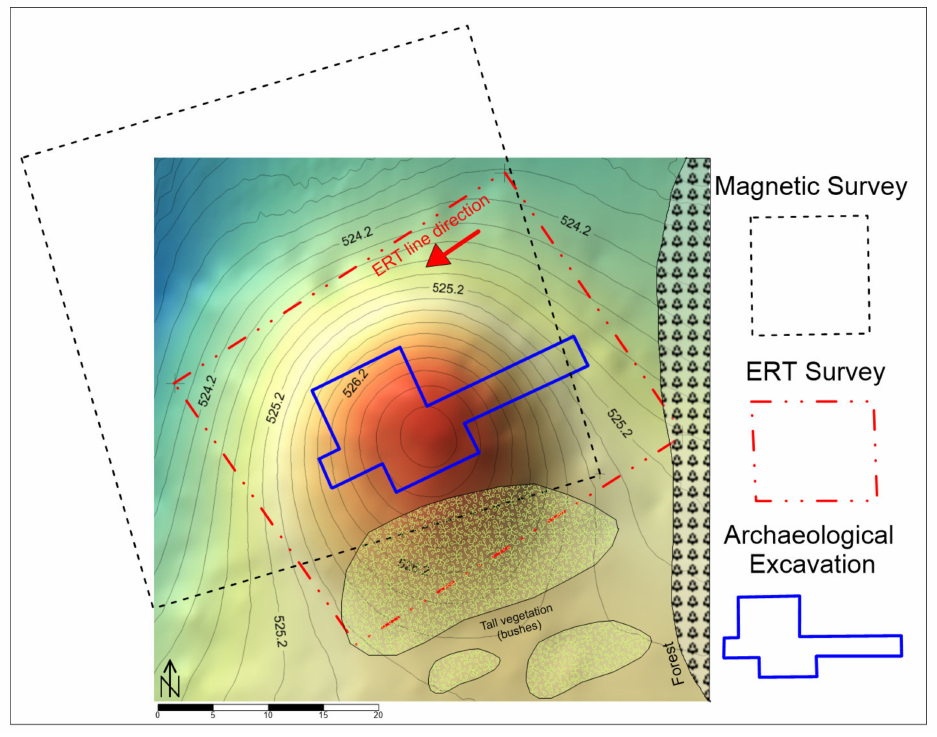
Figure 6. Areas where the geophysical survey was carried out (black for geomagnetic survey and red for electrical resistivity tomography) overlayed by the later archaeological excavation boundaries (with